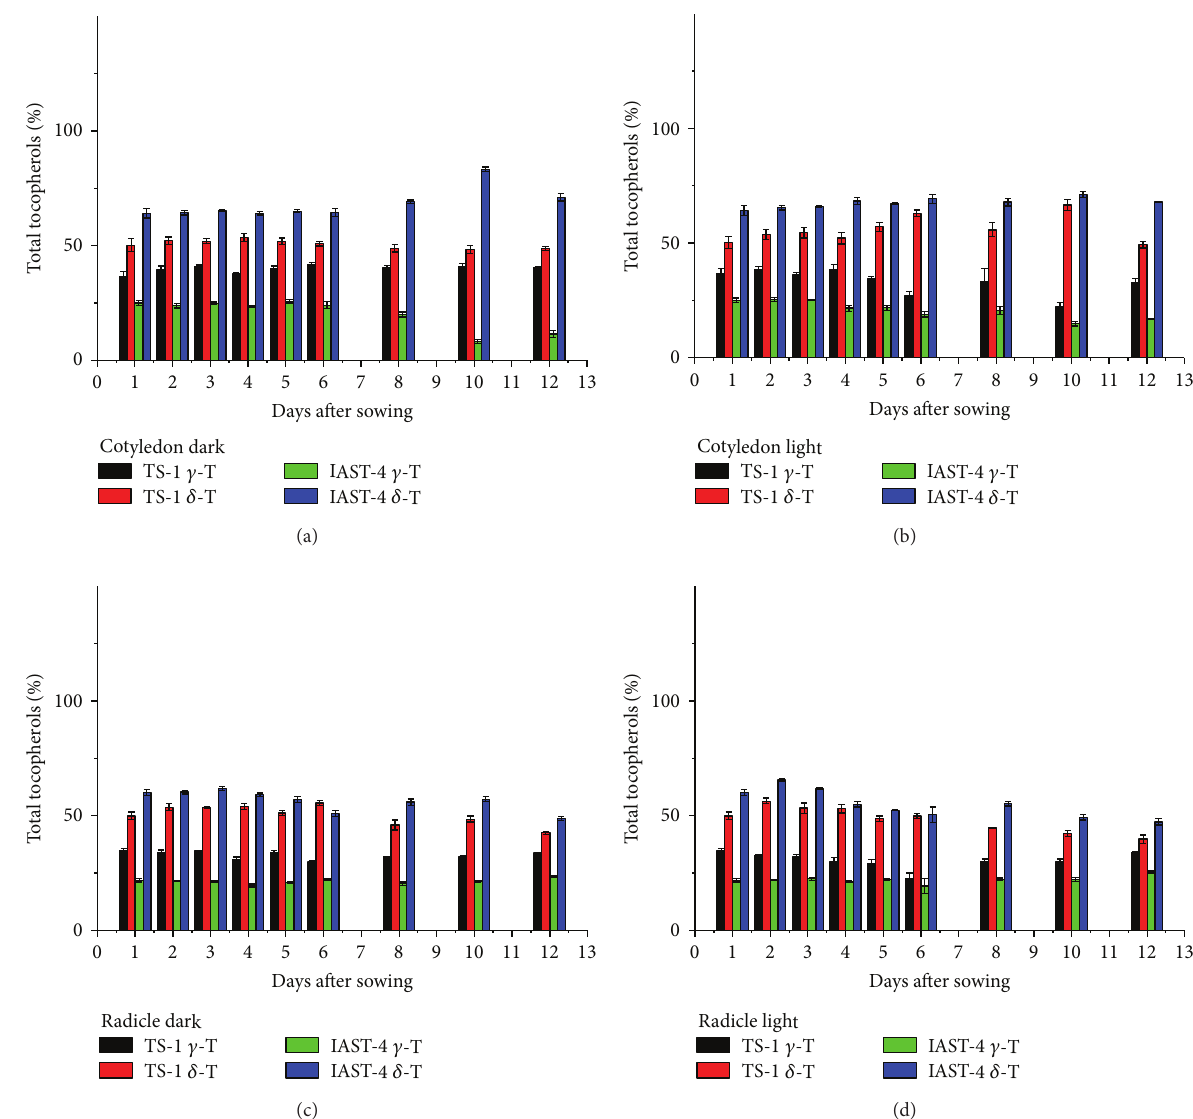
Figure 8: Proportions of 𝛾 - and 𝛿 -tocopherol (% total tocopherols) from 1 to 12 days after sowing in cotyledons and radicles of sunflower lines TS-1 and IAST-4, with different increased levels of 𝛾 - and 𝛿 -tocopherol, from seedlings grown under dark and light conditions. Data are presented as mean ± standard error of three